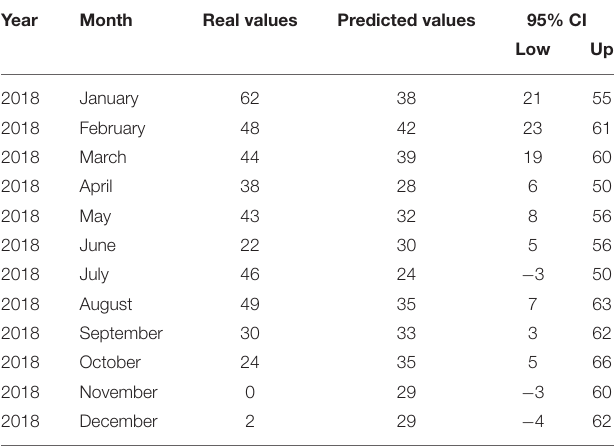
TABLE 5 | Predicted and real values of the number of observed rabies cases in different animal species in Mexico